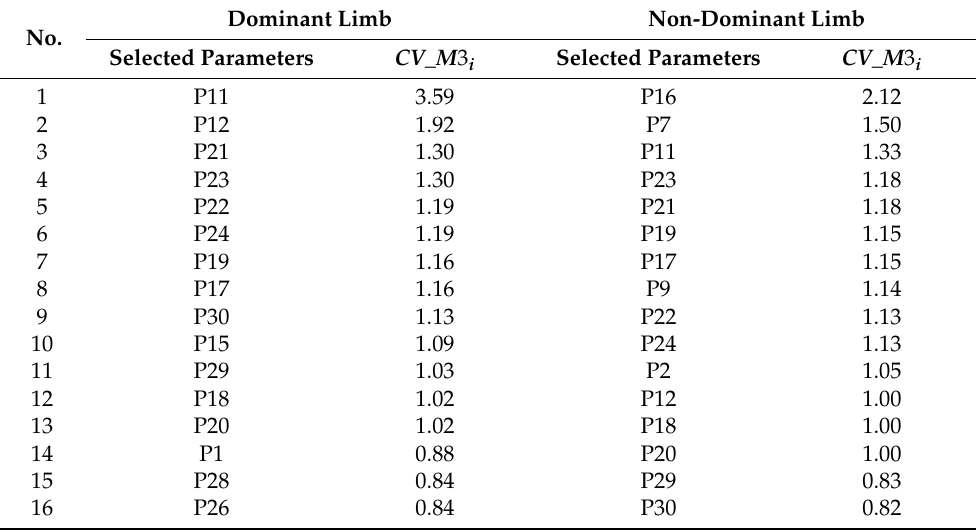
Table 6. Variability values for the parameters selected according to method M3 for the stroke patient